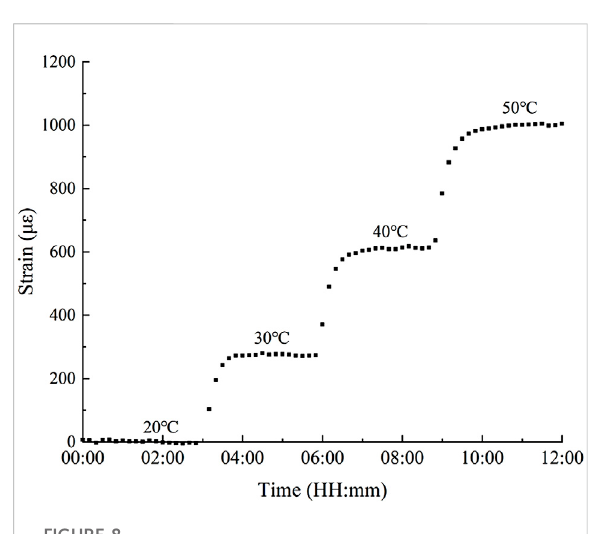
FIGURE 8 Relationship between the temperature of the logging system and the strain of